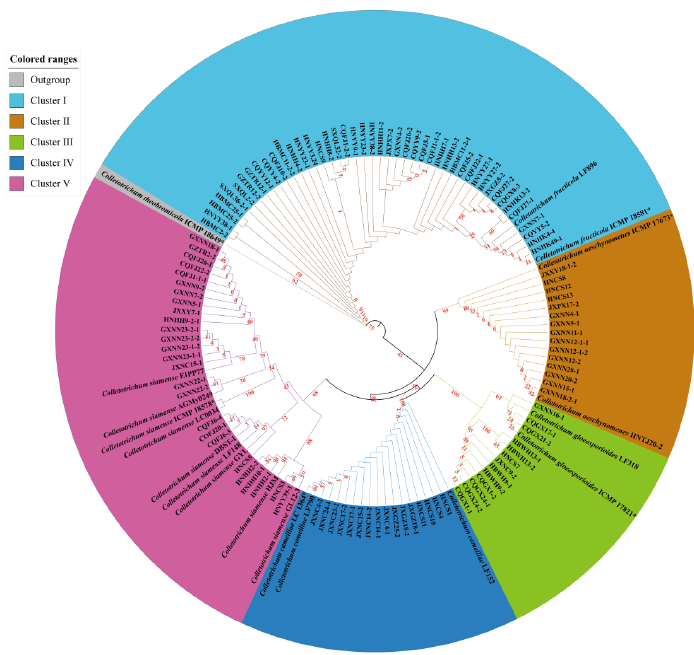
Figure 1. Phylogenetic tree based on ApMat gene sequences using the Neighbor-Joining method in MEGA7 with 1000 bootstrap replications. The isolates obtained in this study are marked in bold. The corresponding sequences for the reference species were retrieved from NCBI GenBank. The numbers at nodes represent their bootstrap support. *: type strain. Phylogenetic analyses using the Neighbor-Joining algorithm showed the 115 isolated strains were clustered into five obvious evolutionary branches with a very high support rate, i.e., C. gloeosporioides , C. fructicola , C. siamense , C. camelliae and C. aeschynomenes , in- cluding forty-five isolates of C. fructicola , fifteen isolates of C. aeschynomenes , twenty-six isolates of C. siamense , and sixteen isolates of C. camelliae . C. fructicola is the predominant species among Colletotrichum of Ca. japonica in China, accounting for 39% ( n = 115) of the isolates tested. (Figure 2).